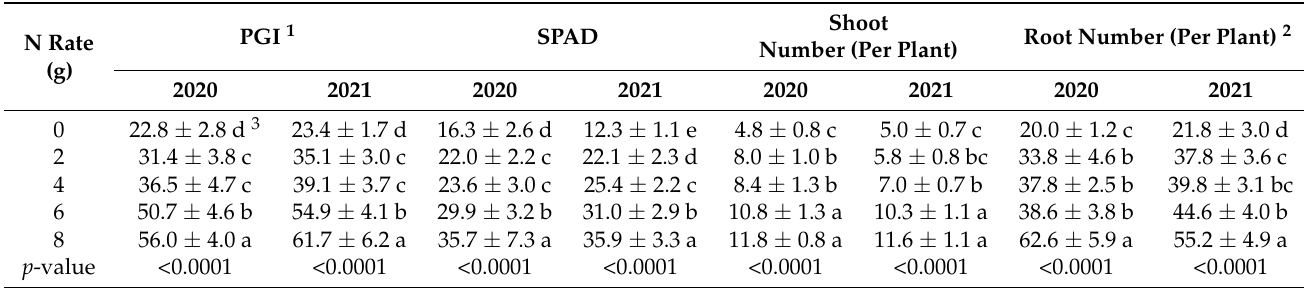
Table 1. Plant growth index (PGI), leaf SPAD value, shoot number, and root number of plants receiving five N rates in 2020 and 2021.